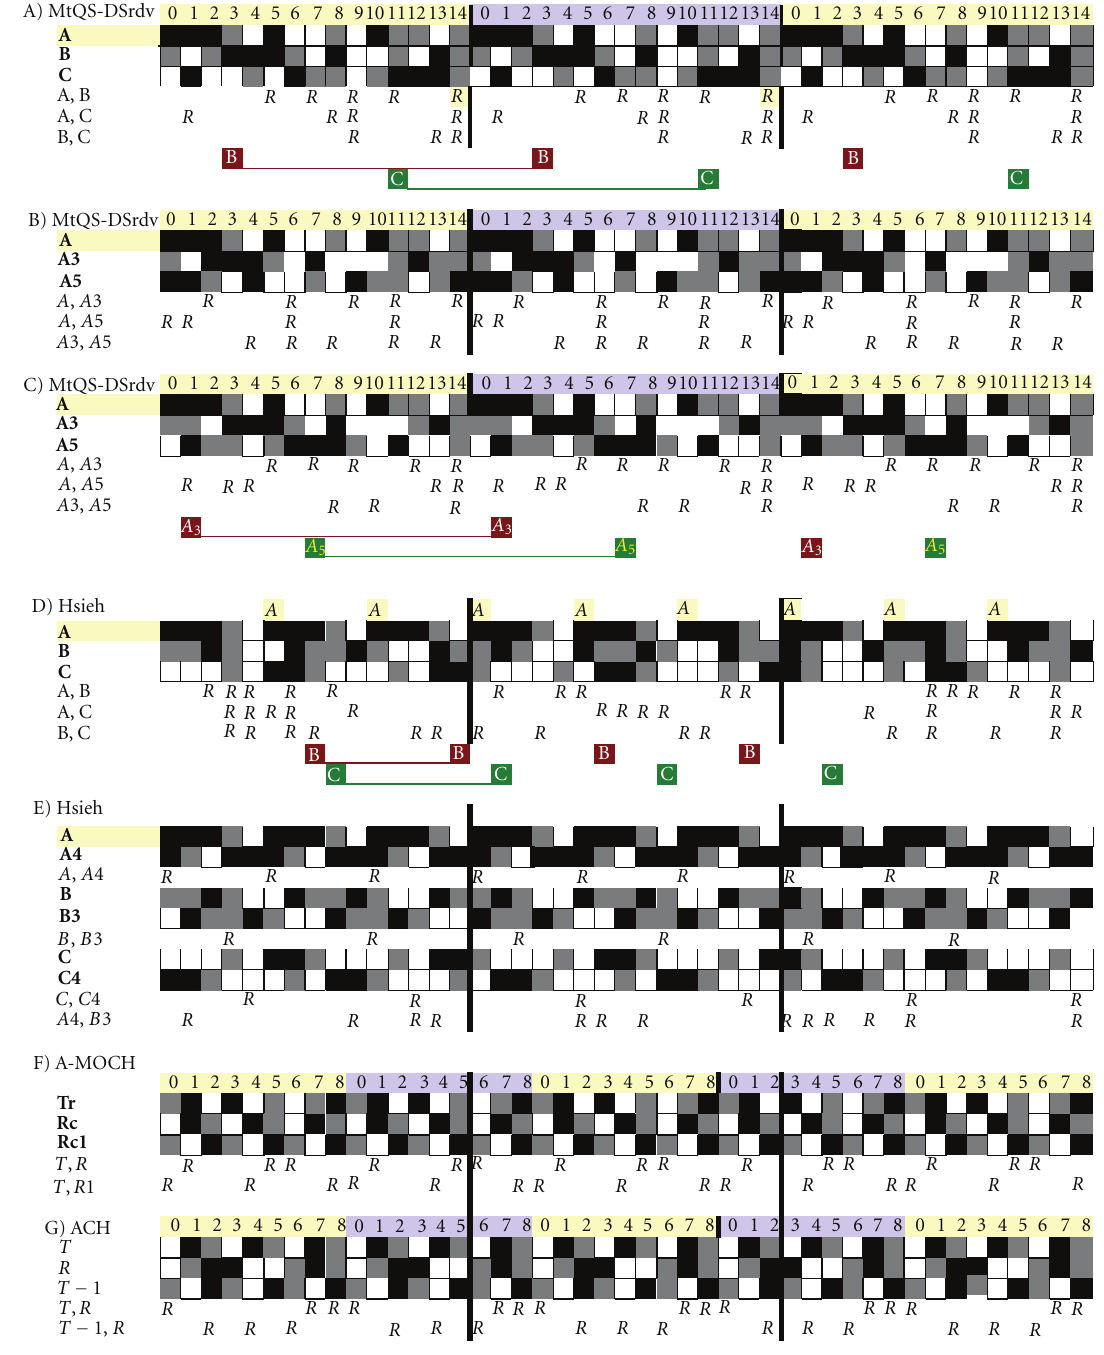
Figure 11: Three available channels: MtQS-DSrdv, Hsien et al. [65], A-MOCH [43], and ACH [63] channel mappings; black square stands for Channel 1, gray square for Channel 2, and white square for Channel 3; R stands for rendezvous.